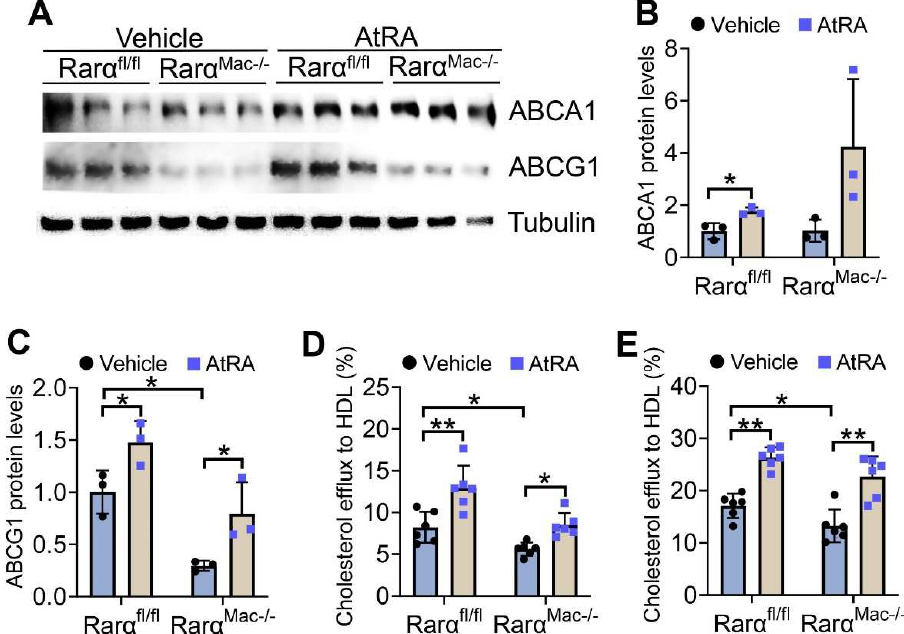
Figure 3. AtRA and RARα promote macrophage cholesterol efflux. ( A – C ) Peritoneal macrophages were isolated from Rarα fl/fl mice or Rarα Mac-/- mice, and then treated with Ac-LDL (25 mg/mL) for 48 h. The cells were also treated with vehicle or AtRA (2 µM). Western blot assays were performed ( A ), and ABCA1 ( B ) or ABCG1 ( C ) protein levels were quantified ( n = 3). ( D , E ) Peritoneal macrophages were isolated from Rarα fl/fl mice or Rarα Mac-/- mice, and then treated with vehicle ( D ) or Ac-LDL (25 mg/mL) ( E ) for 48 h. The cells were also treated with vehicle or AtRA (2 µM). Cholesterol efflux to HDL was performed ( n = 6). In ( B – E ), ordinary two-way ANOVA with Tukey’s multiple comparisons test was used for statistical analysis. All the data are expressed as mean ± SEM. * p < 0.05, ** p < 0.01.